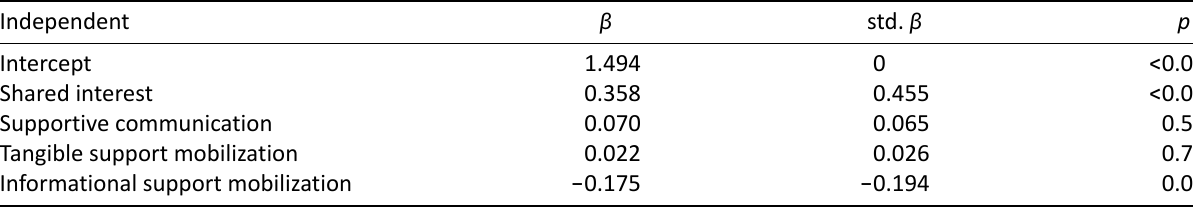
Table 6. Determinant table (regression on reciprocal exchange).